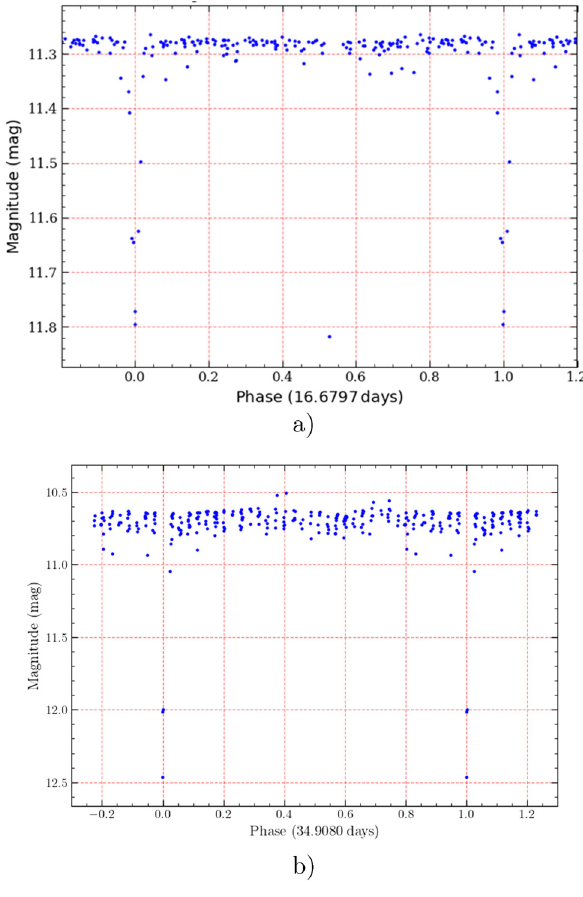
Figure 2: Light curve for ( a ) V1326 Cyg and ( b ) SY And based on ASAS - SN data converted to the period. There are only a few points indicating the shape of the primary and secondary minima.